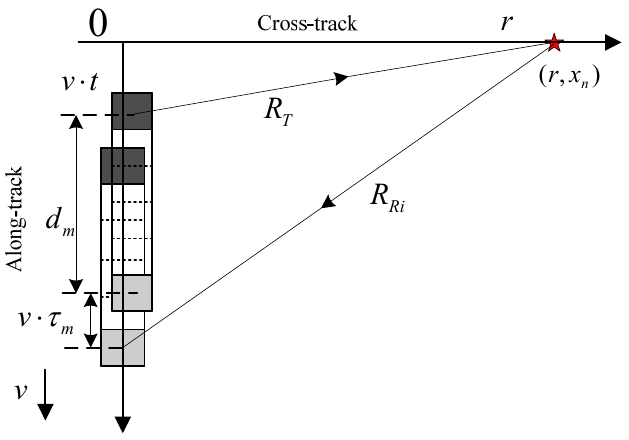
Figure 2. Multi-receiver SAS imaging Figure 2. Multi ‐ receiver SAS imaging geometry.